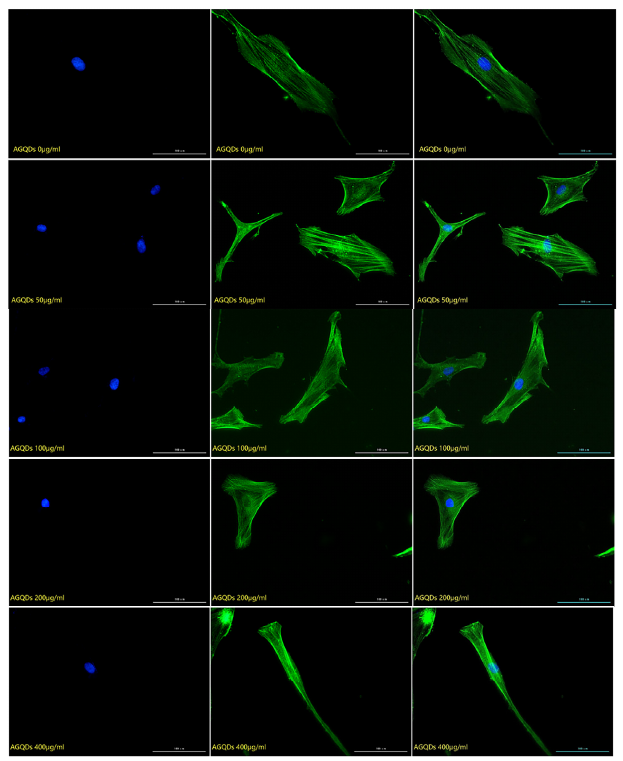
Figure 5. The fluorescence map of FITC-DAPI cytoskeleton staining of HSFs labeled with AGQDs, scale bar: 100 μ m.